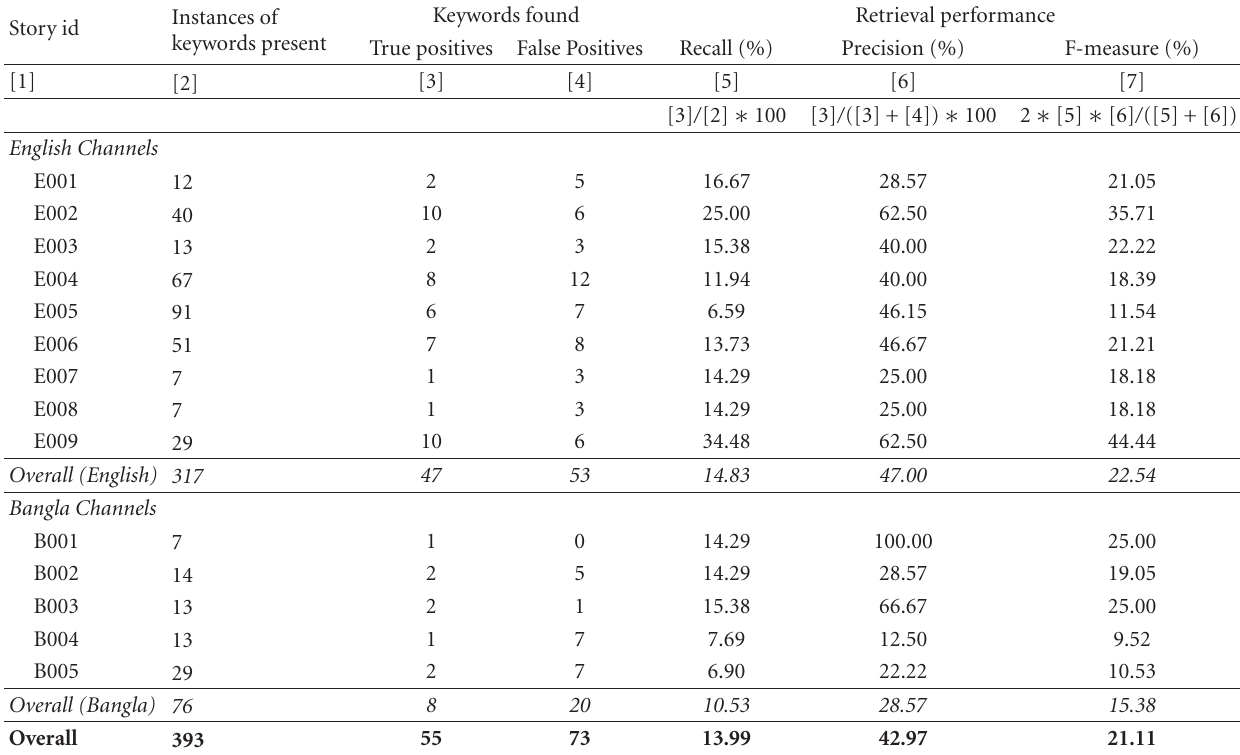
Table 1: Results for keyword spotting in speech with master keyword list.